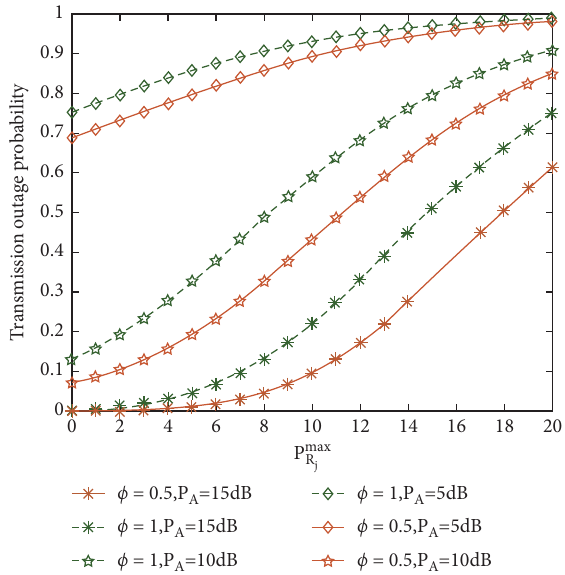
Figure 4: Transmission outage probability versus P max ferent value of P A and ϕ , where N R � 5, σ 2 R � 0 dB , and R � 1 . 5. R j with dif-